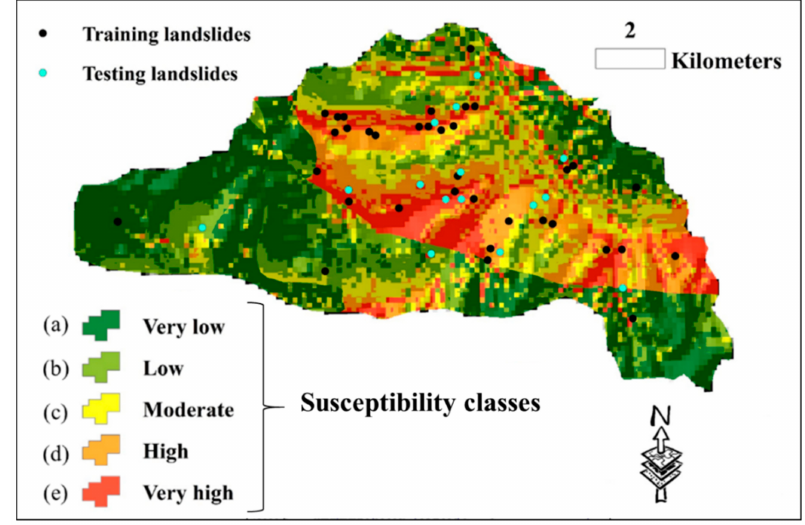
Figure 7. The susceptibility map of the whole area, generated by the EHO-NF